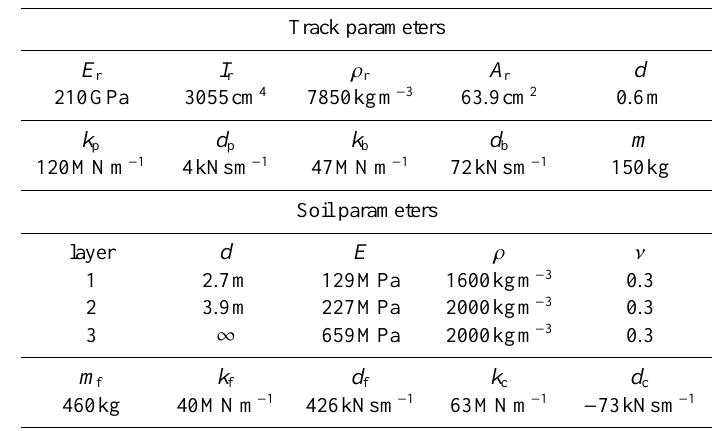
Table 3. Studied site parameters (M´evernies – Belgium).